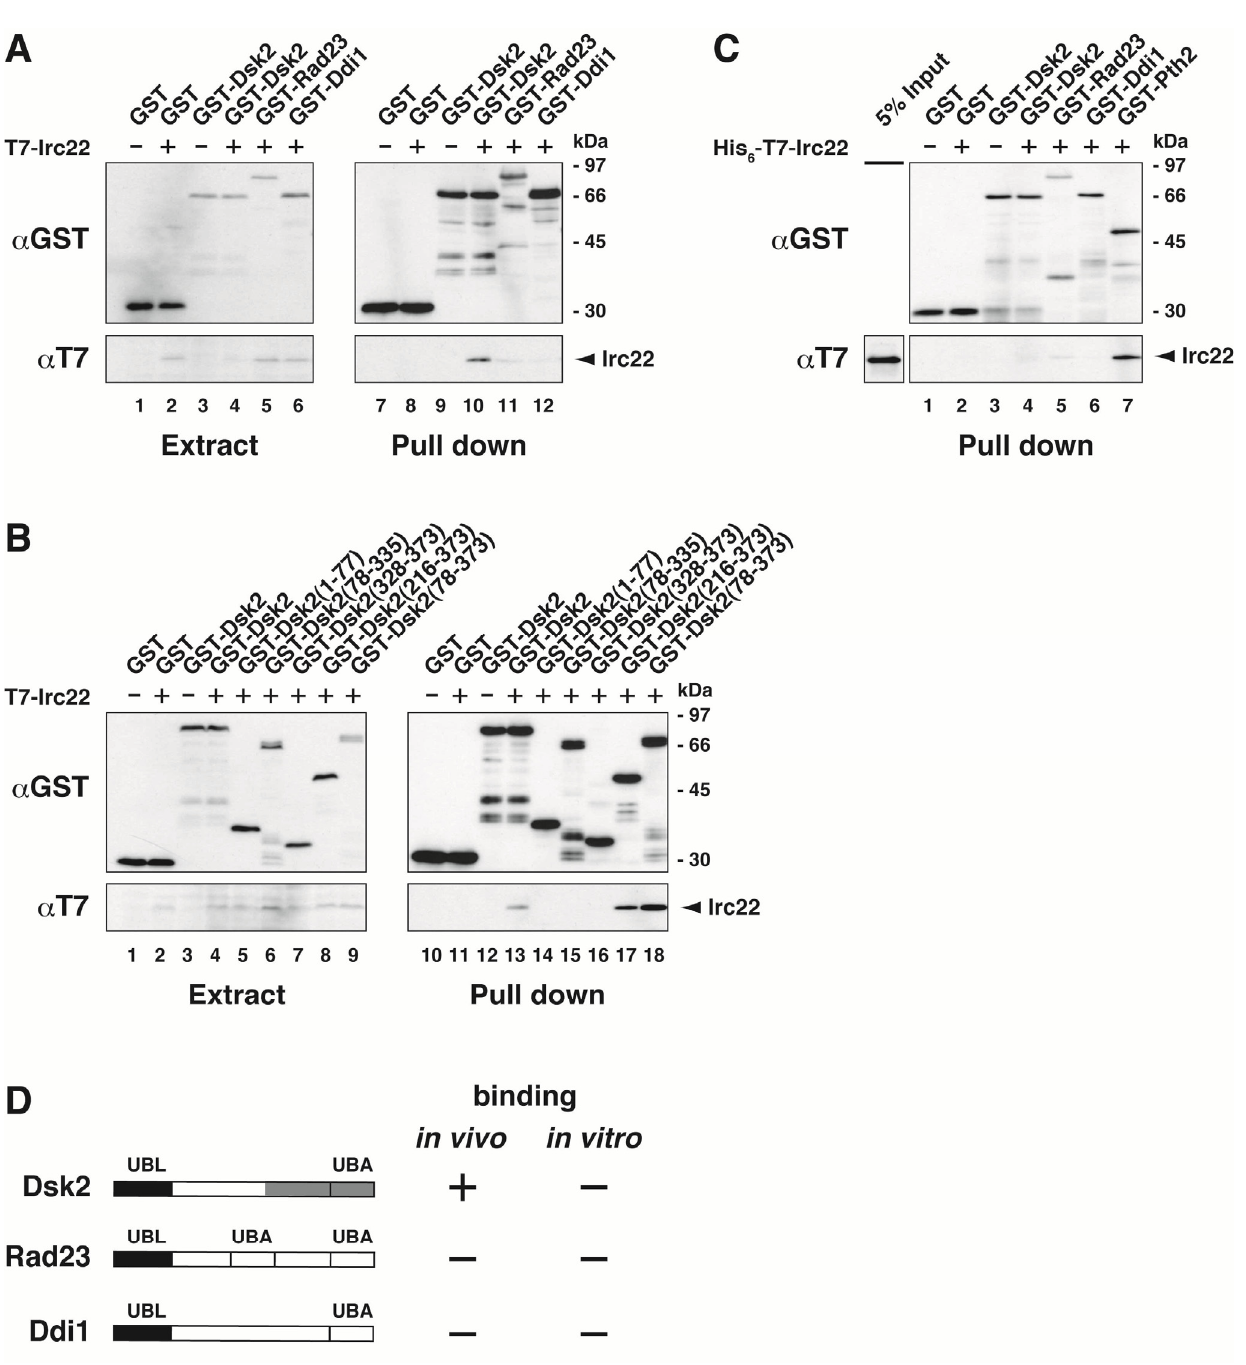
UBA domain of Dsk2